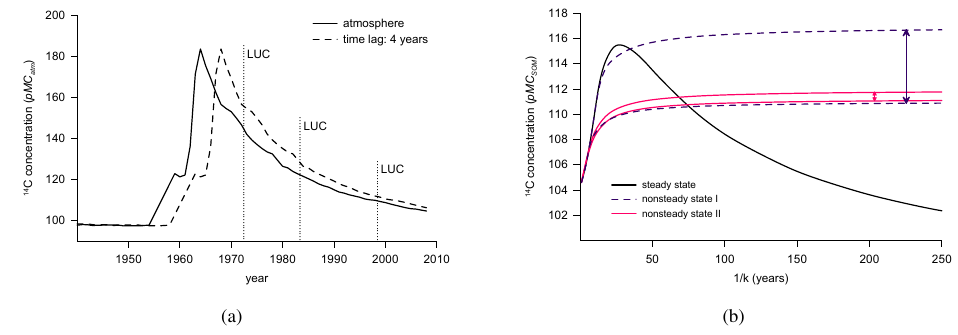
Fig. 1. (a) Time record of the 14 C concentration in the Northern Hemisphere (percent modern carbon: pMC atm = 1 14 C atm / 1000 + 1). The time lag refers to the time period between photosynthetic fixation and addition to soil organic matter (SOM), which is necessary to consider for all root-derived SOM-carbon (C). The atmospheric record, where turnover calculations are based on, is shifted by the lag time value, here 4yr. Vertical dotted lines indicate times of land-use change (LUC) in 1972, 1983 and 1998. (b) The predicted 14 C concentrations in 2008 for a homogeneous SOM fraction (pMC SOM ) as function of turnover times 1 /k , where k is the decomposition rate. The curves represent results for steady-state and accumulation models. The curves produced by accumulation model are based on a fast and slow decomposition rate for the initial C stock and describe two scenarios: nonsteady state I is based on little C accumulation and nonsteady state II is based on high C accumulation. The more C has been accumulated the less important is the C dynamic of the initial C stock for the analyzed time periods.